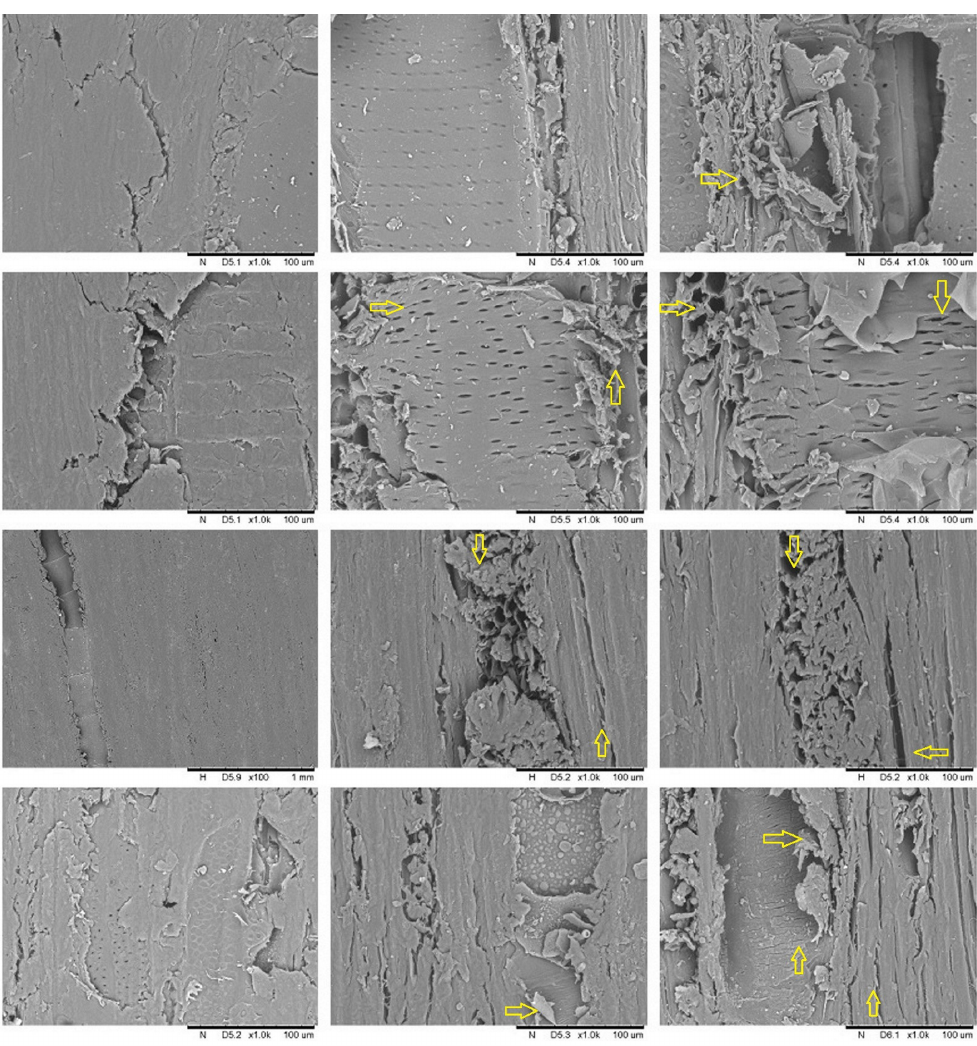
Figure 4. Comparison of microstructure exposed and non-exposed wood surface (from top: garapa, tatajuba, courbaril and massaranduba; from left: fresh wood, after 24 h of UV irradiation, after 4 cycles of artificial weathering); the described changes are marked with yellow arrows.